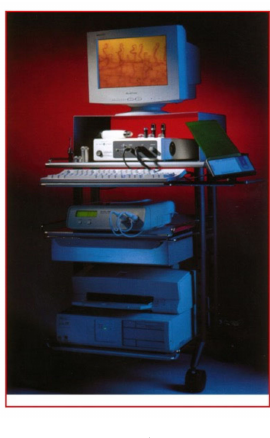
Figure 1. Videocap 100.